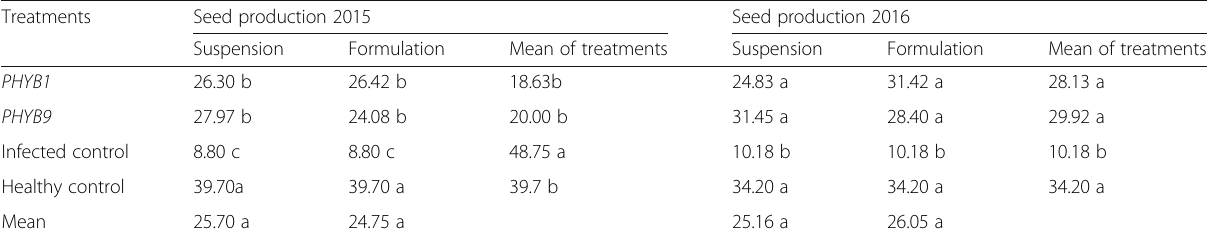
Table 3 Effect of Bacillus simplex as suspension and/or formulation on seed production under field conditions in 2015 and 2016 growing seasons